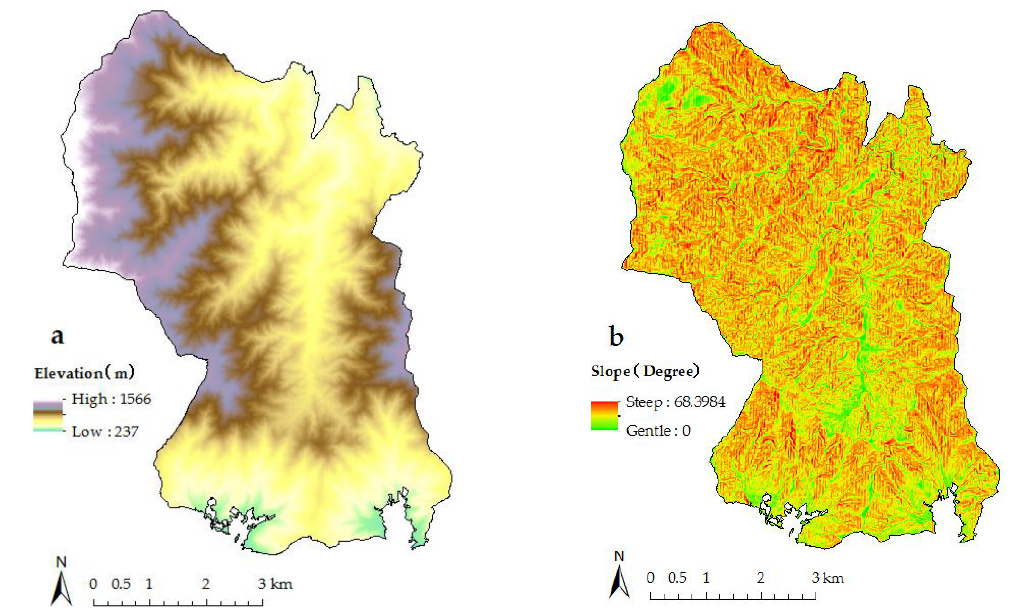
Figure 7. Elevation ( a ) and inclination ( b ) in the study area.